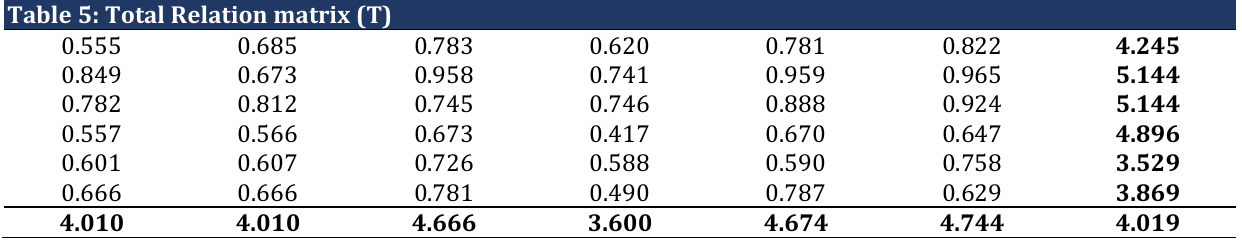
Table 5: Total Relation matrix (T)